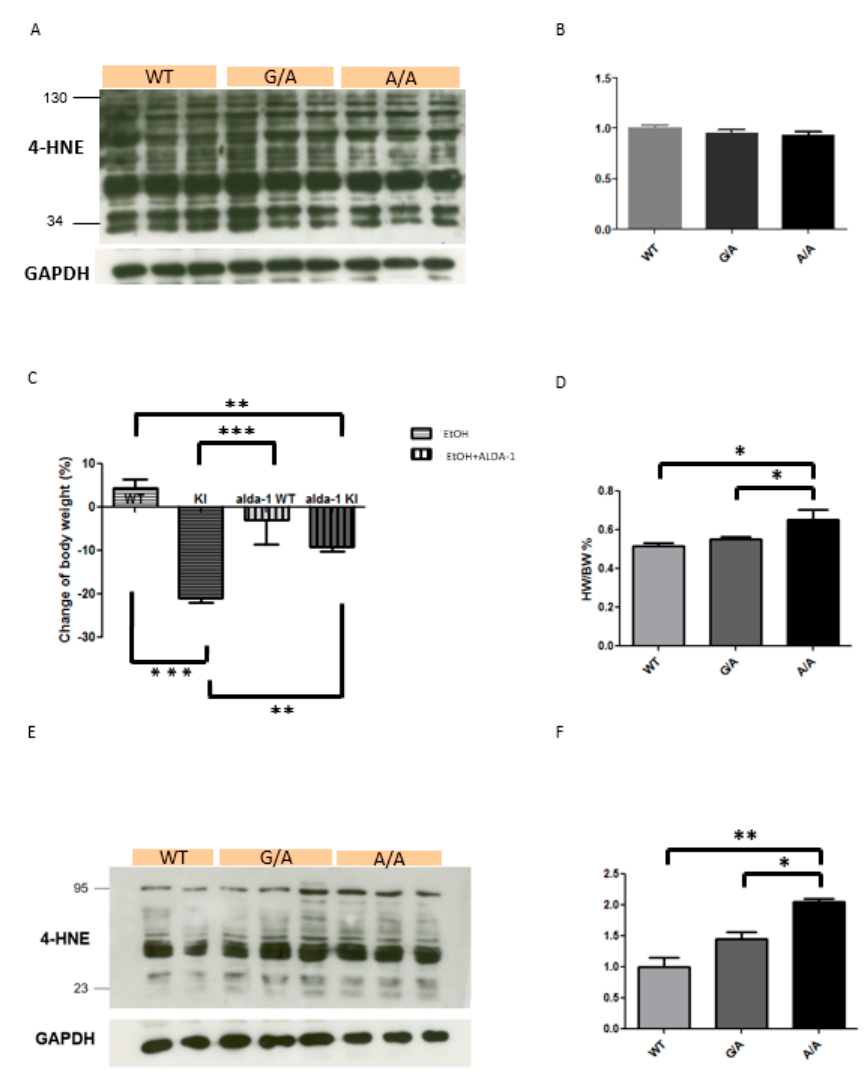
Figure 2. Chronic ethanol intoxication of wild-type (WT) and ALDH2*2 KI mice. ( A ) Representative Western blot and ( B ) quantification relative to GAPDH of 4-hydroxy-trans-2-nonenal (4-HNE) production in mice hearts with the indicated genotypes before chronic ethanol intoxication. ( C ) Body weight (BW) and ( D ) ratio of heart weight (HW) and BW of WT and ALDH2*2 KI mice treated with a liquid diet containing 5% ethanol with and without Alda-1 (20 mg / kg per day) for 10 days, then a single dose of ethanol (5 g / kg BW, 20% ethanol) at day 11. ( E ) Representative Western blot and ( F ) quantification relative to GAPDH of 4-HNE production in mice hearts with the indicated genotypes after chronic ethanol intoxication. Each value represents the mean ± SE of at least three independent experiments. KI, heterozygous and homozygous ALDH2*2 KI mice; EtOH, ethanol; * p < 0.05, ** p < 0.01, *** p < 0.001.